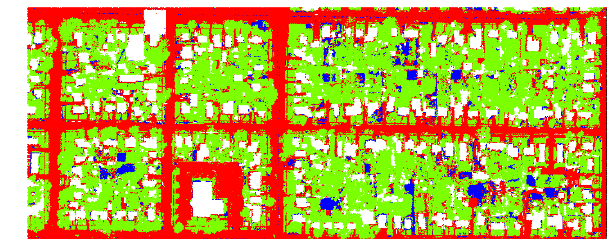
Figure 10. The classification result of rough surfaces, the points colored by blue are vegetation, and the points colored by red are vehicles.